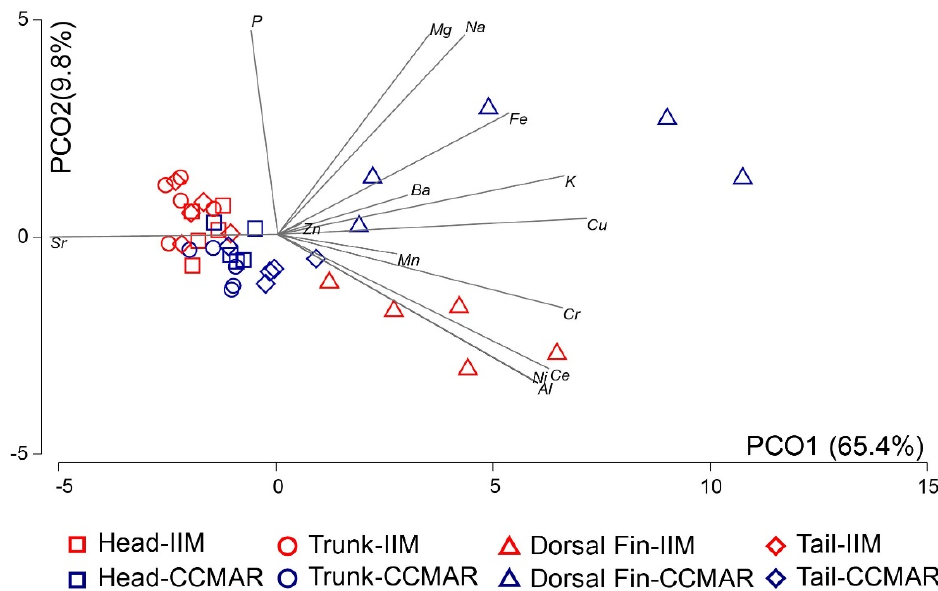
Figure 3. Principal coordinates analysis of the elemental fingerprints of four body parts (head, trunk, dorsal fin, and tail) of long-snouted seahorses ( Hippocampus guttulatus ) from Instituto de Investigaciones Marinas (IIM) (Galicia, Spain) and Centro de Ciências do Mar (CCMAR) (Algarve, Portugal) ( n = 5). Vector overlay Pearson correlations of elemental composition with PCO axes are shown if |r| > 0.20.